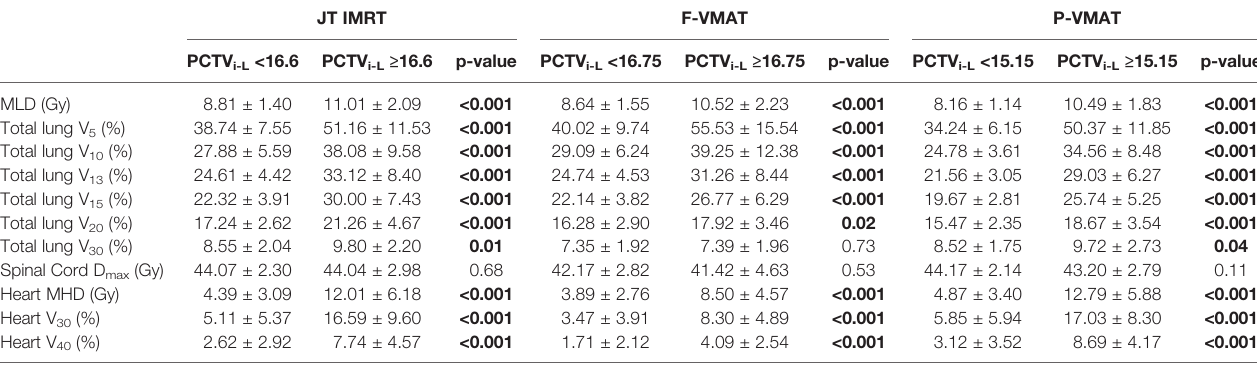
TABLE 5 | Dosimetric parameters with grouping PCTV inferior length. JT IMRT F-VMAT